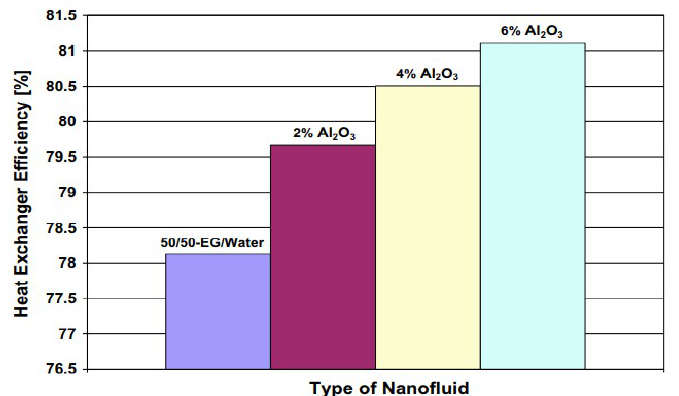
Figure 8. Illustration of the effect of various concentrations of Al 2 O 3 nanofluid on the heat exchange efficiency of heat recovery of an engine [66]. Table 1. Experimental studies of nanofluids for vehicle system